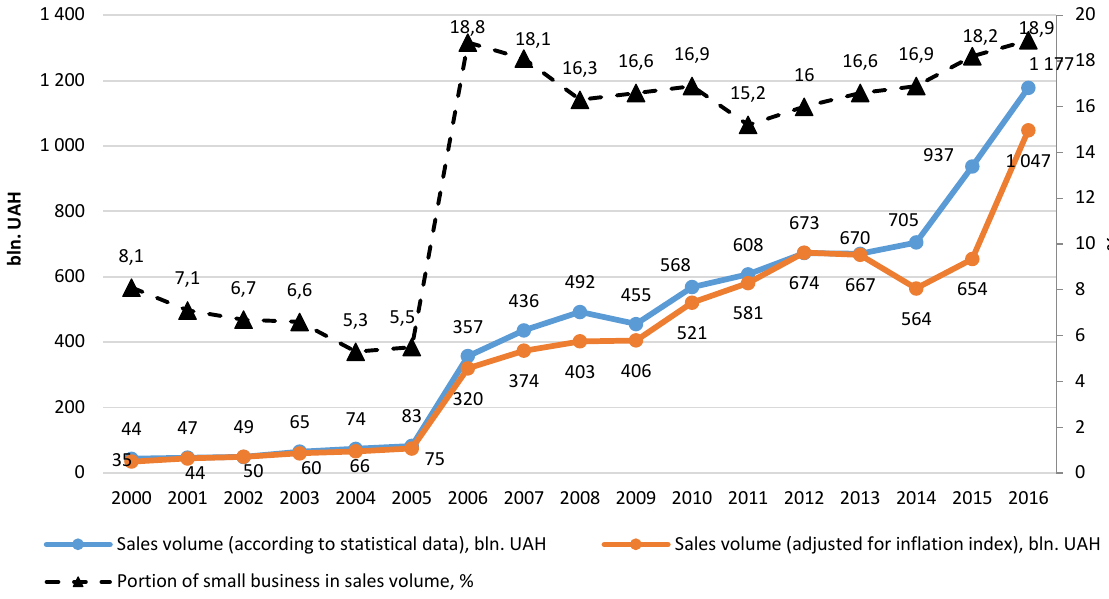
Figure 1. The sales volume of small business and the portion of small business in the sales volume of Ukraine in